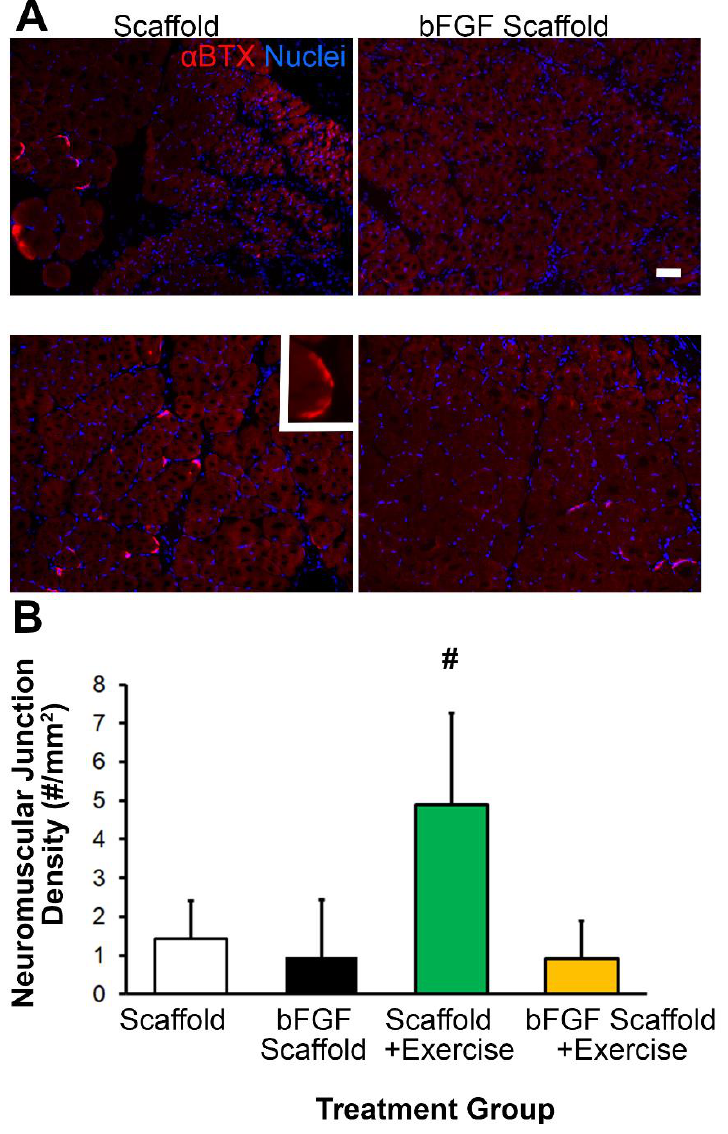
Figure 6. Effect of bFGF or exercise on re-innervation at the site of VML. ( A ). Representative microscopy images adjacent to the site of scaffold implantation depict nerve regeneration, based on α-bungarotoxin (αBTX) staining (red). Inset shows a magnified view of αBTX staining. ( B ). Quantification of neuromuscular junction density as the total number of neuromuscular junctions (αBTX) divided by the area formed by a 500-μm radial distance surrounding the scaffold. Shown are mean ± SD ( n = 5). # denotes statistically significant comparison to all other groups ( p < 0.05). Scale bar: 50 μm.